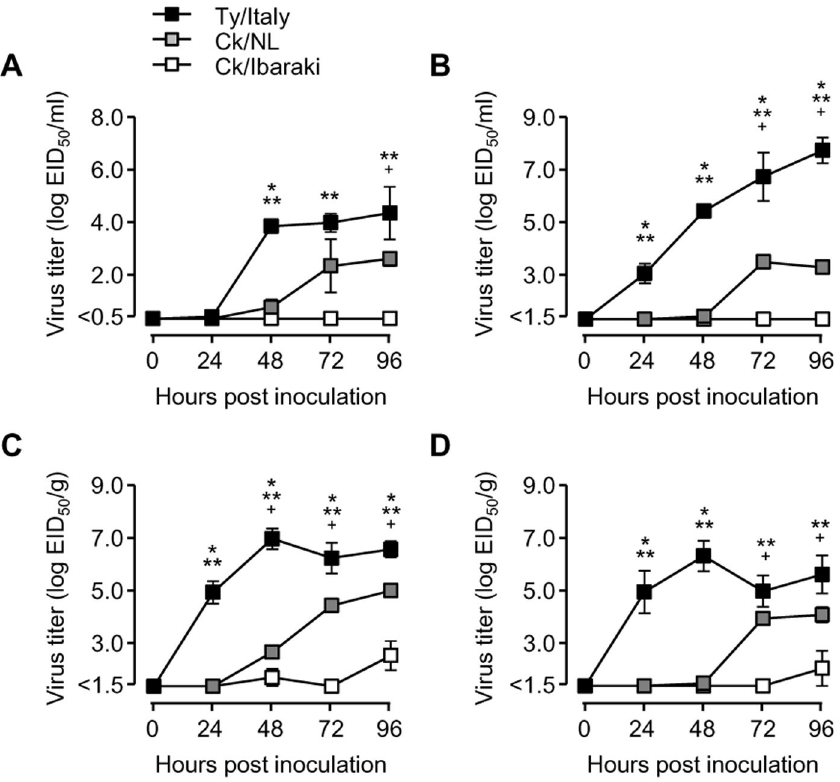
Figure 2. Comparison of HPAIVs and LPAIV proliferation. After 10 6.0 EID inoculated into chickens, peripheral blood ( A ), brains ( B ), lungs ( C ), and spleens ( D ) were collected every 24 h, and infectivity titers were determined by inoculation of 10-day-old embryonated eggs. The mean values with corresponding standard errors from 3 chickens are shown. * p <0.05 between Ty/Italy and Ck/NL, ** p <0.05 between Ty/Italy and Ck/Ibaraki, + p <0.05 between Ck/NL and